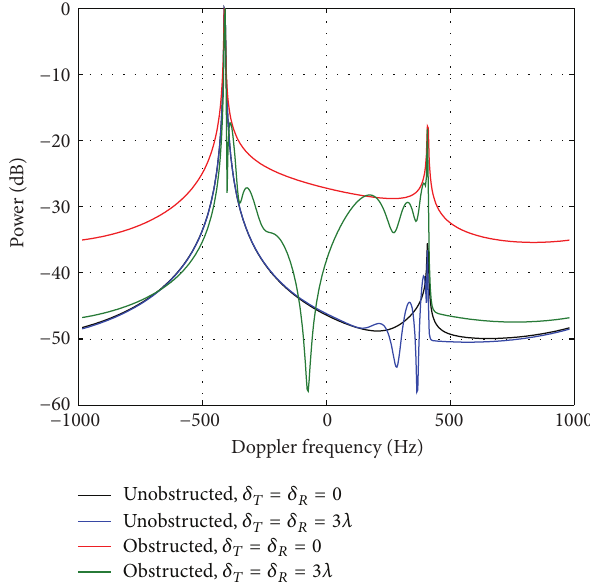
Figure 13: Doppler PSDs for SISO (𝛿 𝑇 = 𝛿 𝑅 = 0) and MIMO (𝛿 𝑇 = = 3𝜆) cases in the obstructed and unobstructed 𝛿 𝑅